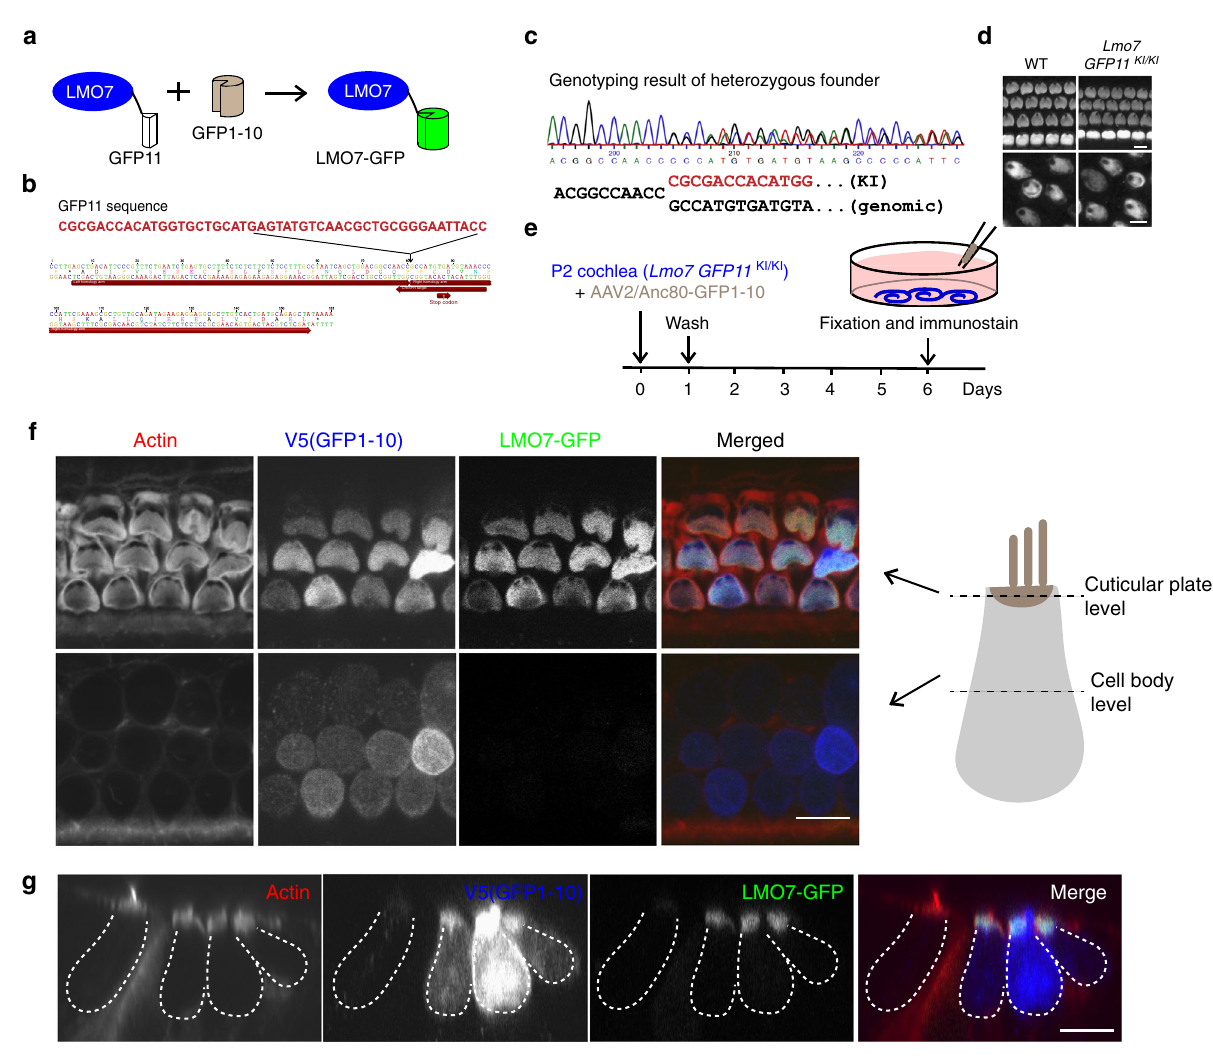
Fig. 2 Localization of endogenous LMO7 using the split-GFP approach. a Schematic diagram of the split-GFP approach to label tagged endogenous LMO7. b Illustration of CRISPR/Cas9-mediated GFP11 knock-in strategy. Genomic sequence surrounding the stop codon of mouse Lmo7 . Highlighted are the CRISPR target sites and the left and right homology arms used for the homology-directed repair. c Sequencing chromatogram of the modi fi ed locus, from the Lmo7-GFP11 KI founder mouse. d Immuno fl uorescence localization of LMO7 in P4 WT and Lmo7-GFP11 KI /KI cochlea and utricle. e Depiction of experimental paradigm for transduction of explants of Lmo7-GFP11 KI cochlea with AAV2/Anc80-GFP1-10. The cochleae were dissected and transduced with AAV2/Anc80-GFP1-10 for 24 h. After replacement of culture medium, cultures were maintained for 5 days, fi xed, and immunostained. f Optical sections at the level of the cuticular plate and cell body are shown. Reconstituted LMO7-GFP expression localizes to the cuticular plate but not the cell body level. Scale bar, 5 μ m. g Side view of reconstituted LMO7-GFP expression enriched in the cuticular plate of outer hair cell. Scale bar, 5 μ